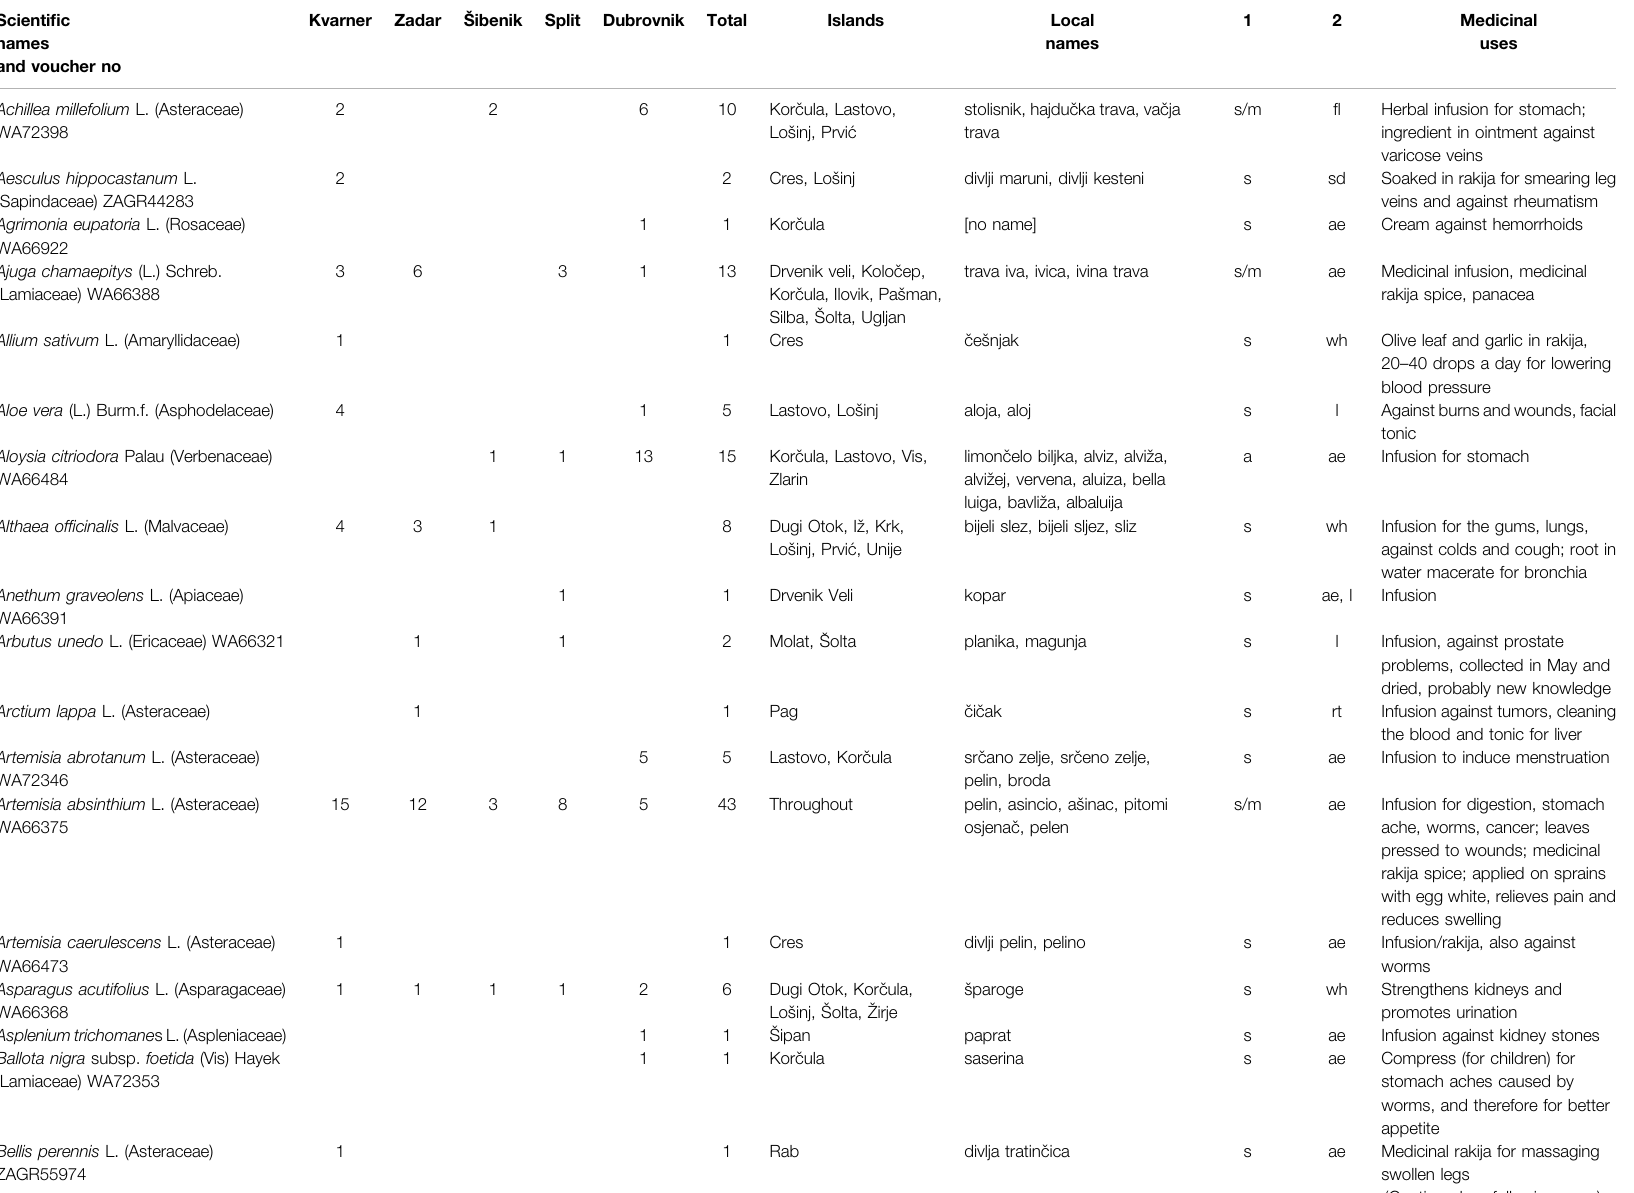
TABLE 2 | List of species used medicinally or as herbal tea in the study